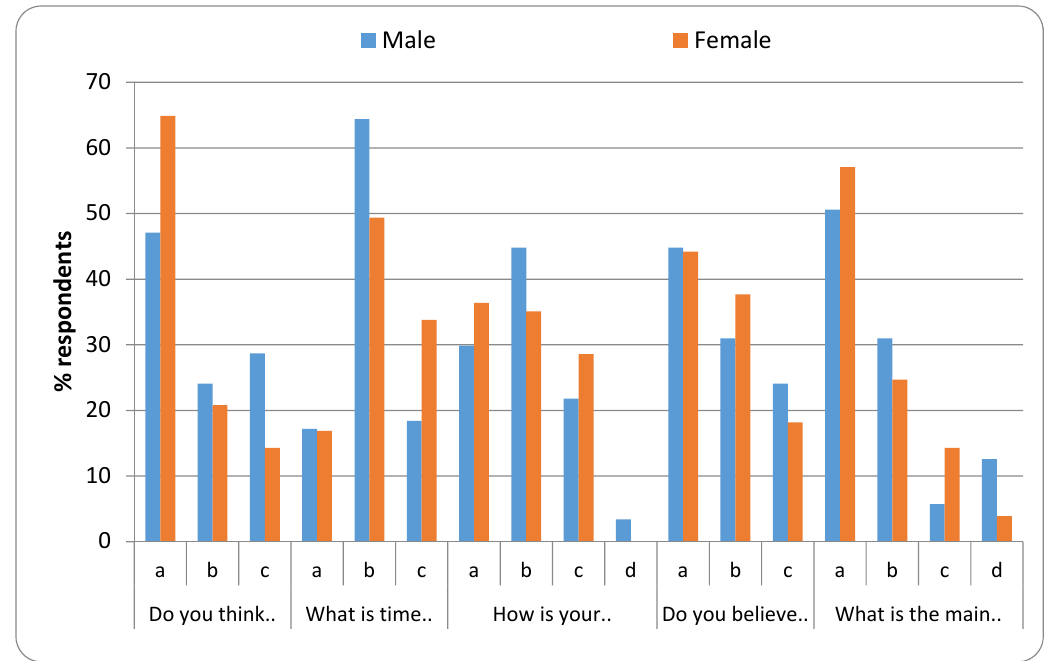
Figure 4. Distribution of responses related to practice according to gender. Healthcare 2020 , 8 , x